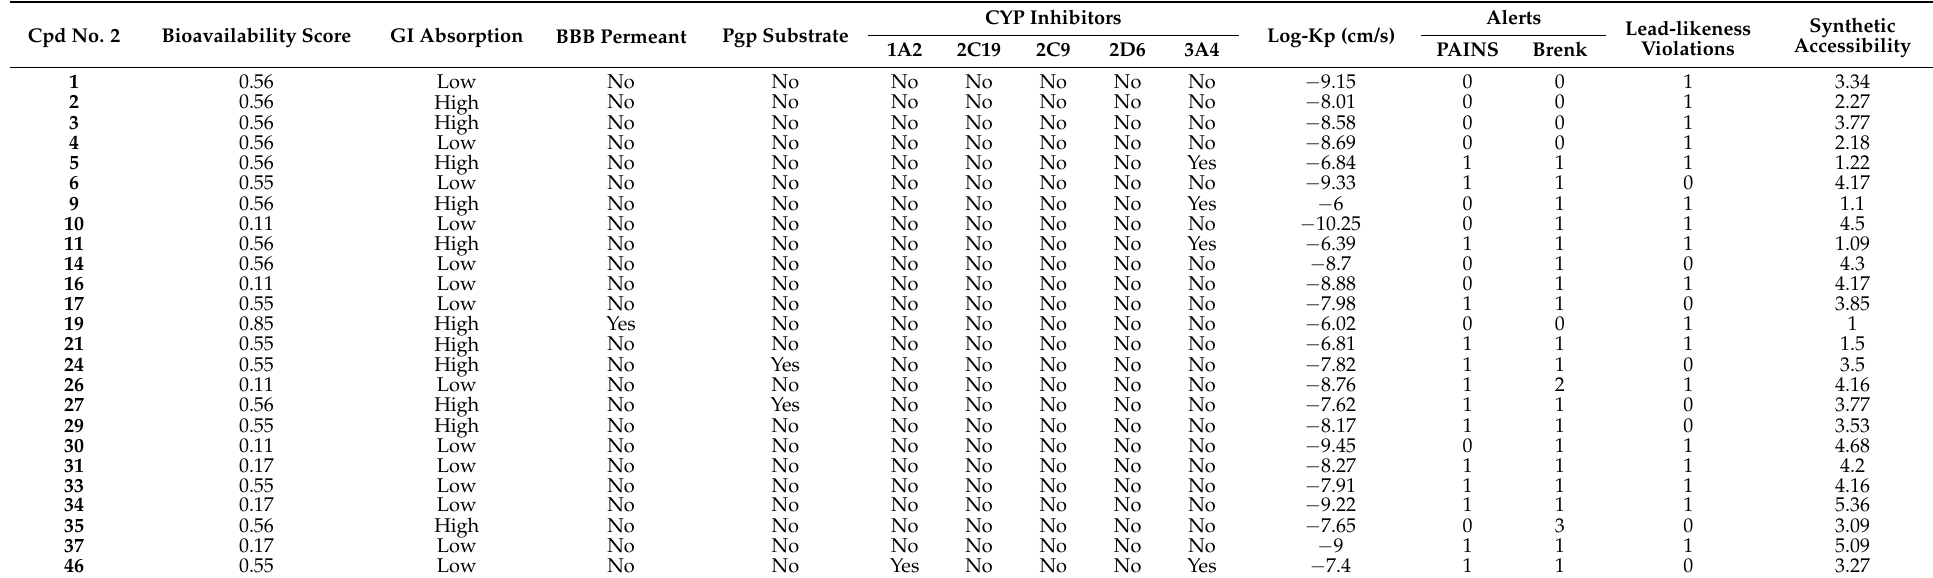
Table 7. Pharmacokinetics results of the identified compounds from E. divinorum